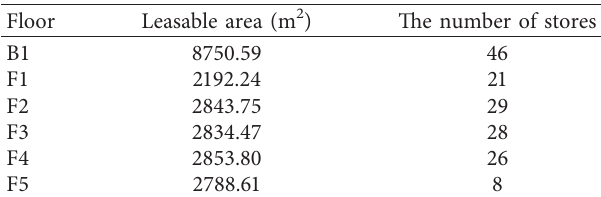
Figure 5: Original tenant mix layout. (a) Original tenant mix layout, B1. (b) Original tenant mix layout, F1. (c) Original tenant mix layout, F2. (d) Original tenant mix layout, F3. (e) Original tenant mix layout, F4. (f) Original tenant mix layout, F5. ∗ In ( i , h ), i represents the retail type of the tenant, and h represents the brand level of the store. The shaded area represents the nonrental area. Table 5: Physical